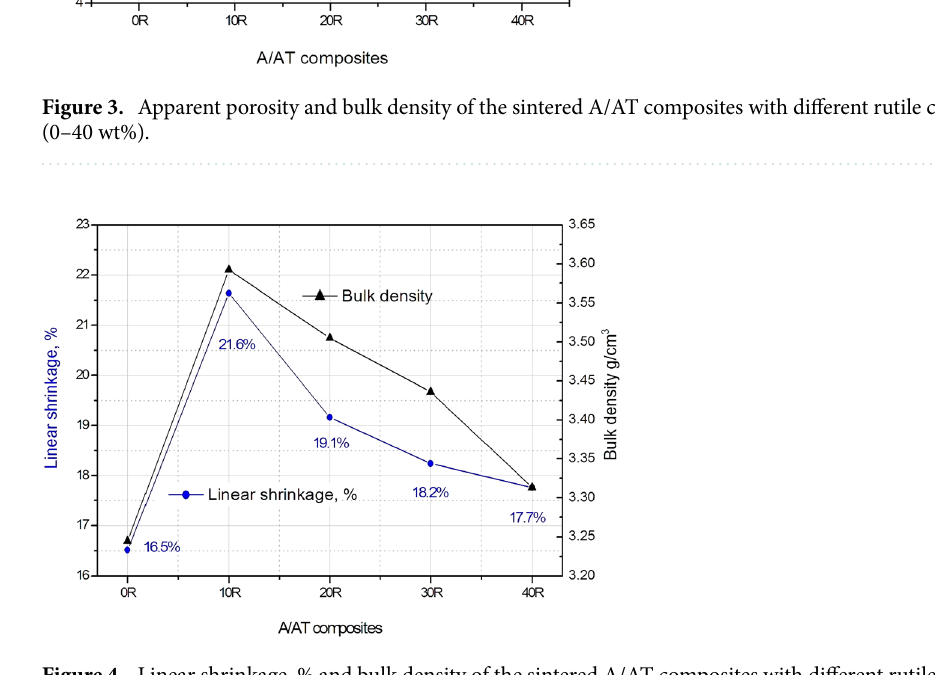
Figure 4. Linear shrinkage, % and bulk density of the sintered A/AT composites with different rutile content (0–40